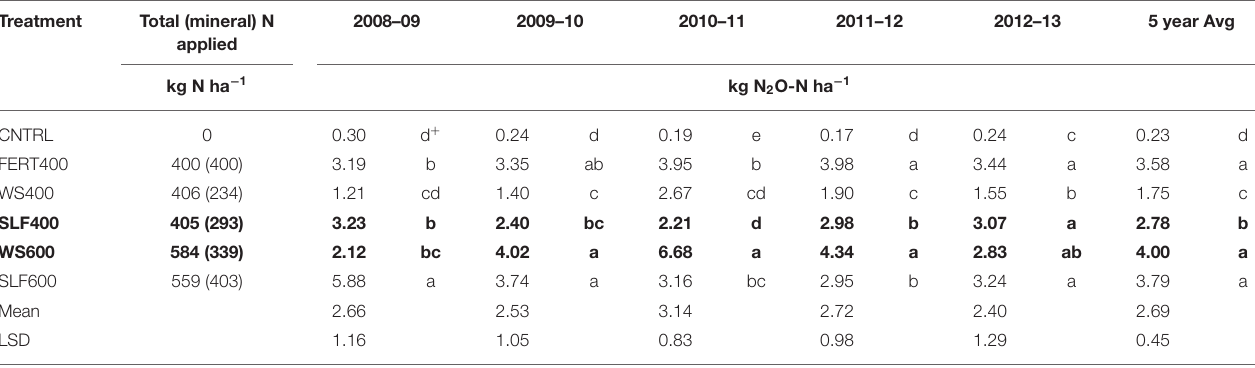
TABLE 4 | Annual N 2 O-N emissions from perennial grass plots treated with whole slurry, separated liquid fraction, mineral fertilizer, and untreated control over a 5 year period in south coastal BC. Treatment